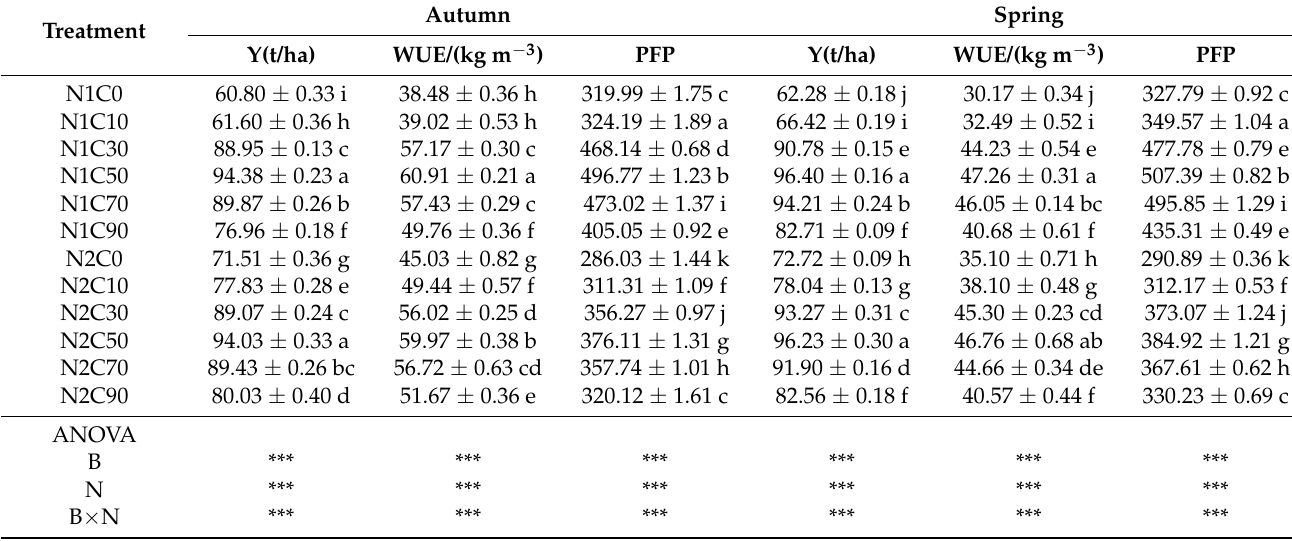
Table 6. Yield of tomatoes (Y), water use efficiency (WUE), and partial-factor productivity of nitrogen (PFP) as affected by the addition of biochar (C0, C10, C30, C50, C70, and C90) and N fertiliser (N1 and N2).